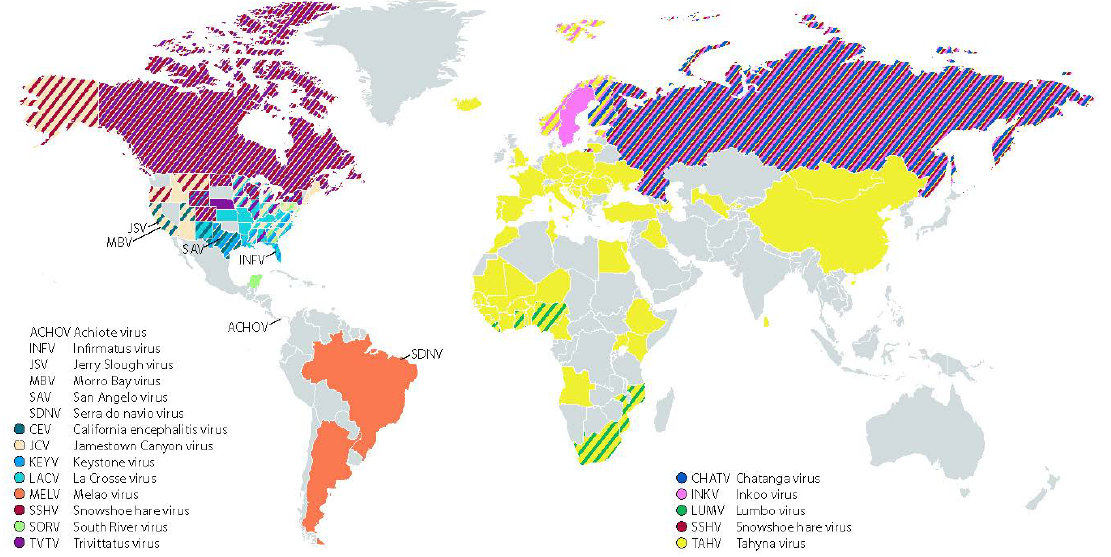
Figure 2. Map of the geographical distribution of the California serogroup viruses, expanded from Figure 1A in [21]. Geographic distribution is based on positive serology of humans and animals, mosquito isolations of virus, and probable and confirmed human